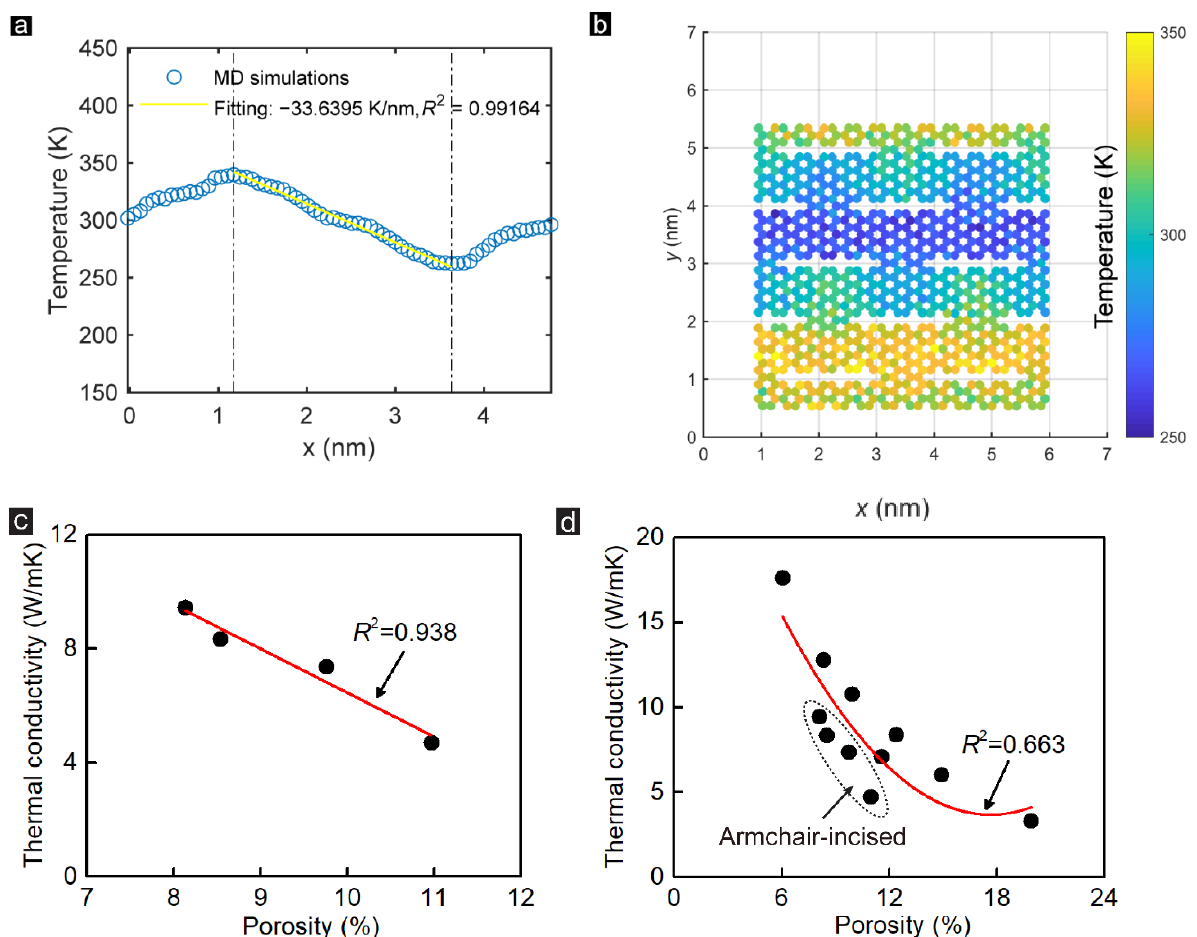
Figure 6. ( a ) Time-averaged temperature distribution of each atom along the direction perpendicular to the armchair-incised GK incisions (Sample AC_3_1) during the simulation process. ( b ) Snapshots of the temperature distribution of Sample AC_3_1 after one nanosecond of heat conduction. Relationship between the DD and the thermal conductivity on ( c ) armchair-incised GK in Group_3 and ( d ) all established GK membranes without stretching.